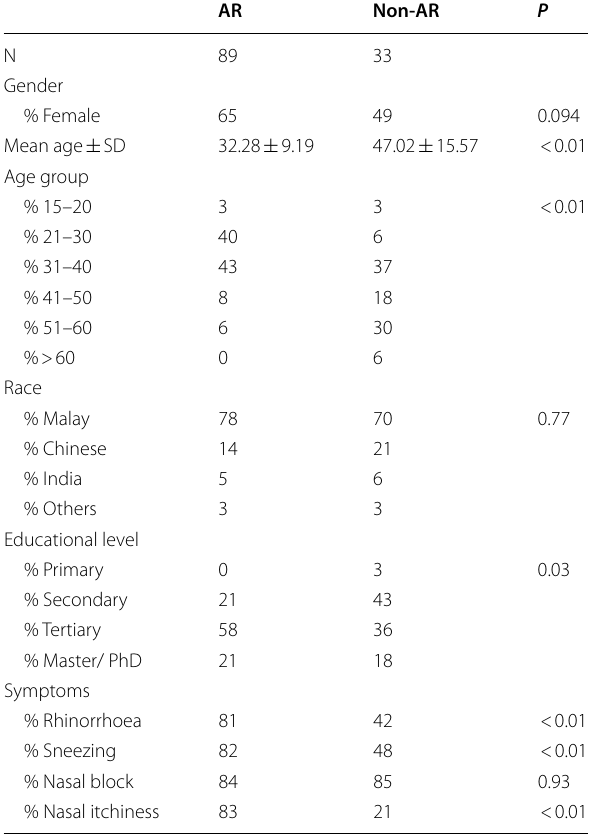
Table 3 Summary of the demographic data of participants in the present